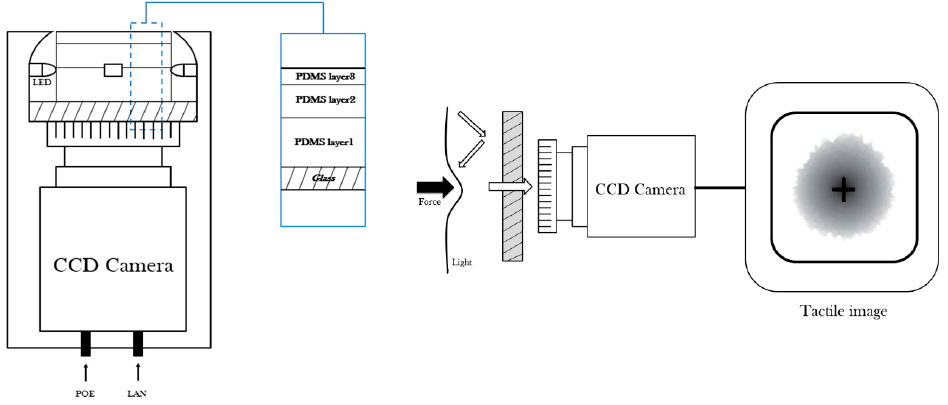
Figure 3. Schematic of the optical tactile